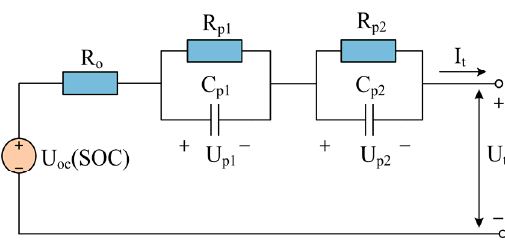
Figure 2. Schematic diagram of the battery equivalent circuit